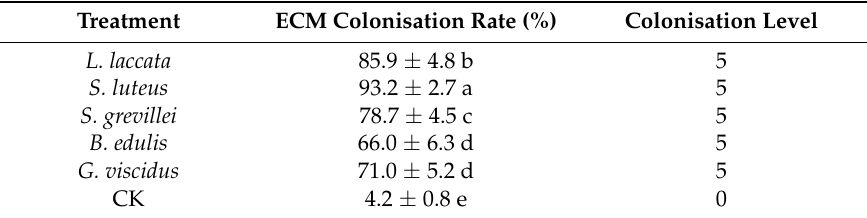
Table 1. ECM colonisation rate (%) P. tabulaeformis seedlings: L. laccata , S. luteus , S. grevillei , B. edulis , G. viscidus , and CK.